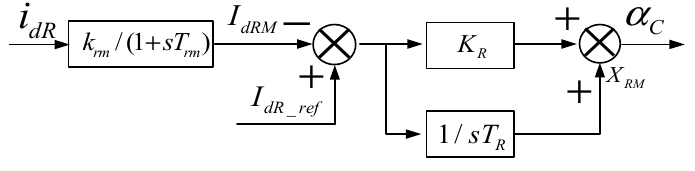
Figure 4. Block diagram of rectifier control.